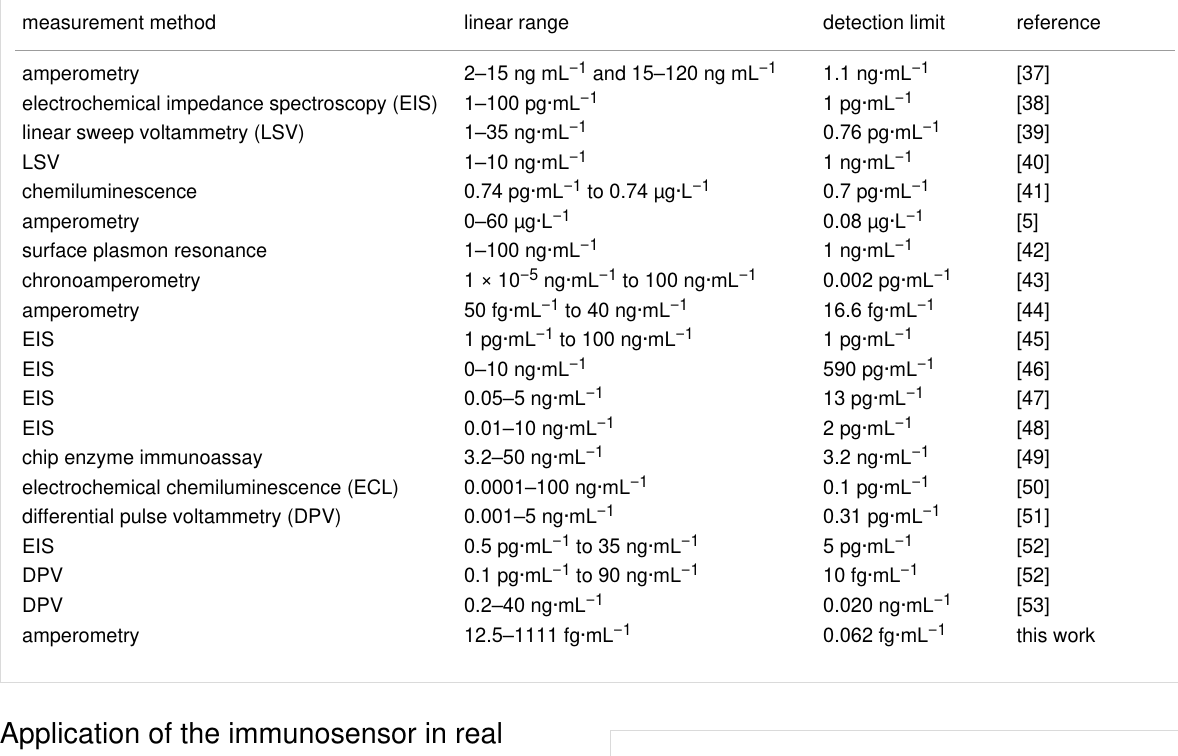
Table 1: Comparison of various sandwich-type immunosensors and immunoassays for the detection of PSA. measurement method